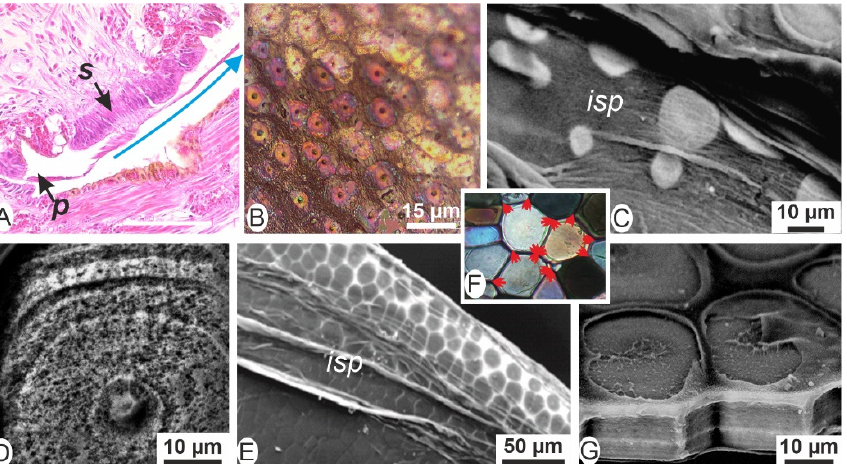
Figure 6. Role of the periostracum in the formation of the shell outer layer. ( A ) Histological view showing the origin of the periostracum ( p ) in the deeper part of the outer mantle grove and the first secretion onto its inner surface ( s )—Image credit: A. Fougerouse, DRM. Periostracum is continu- ously secreted (on a stepping mode) and it progresses towards the shell growth edge (blue arrow). ( B ) Statistical deposition of the organic centers surrounded by the earliest secondary deposition. ( C ) Mineralized disks whose diameters progressively increase. ( D ) Stepping mineralization of the disks forming concentric rings surrounding the initial center. ( E ) Disk reaching the shell growing edge visible through the internal side of the periostracum ( isp ). ( F ) Deposition of calcium carbonate by the mantle contributes to create the rigid shell. ( G ) Oblique view of the shell prisms showing their outer sides made by the partly decayed periostracum with the underlying disks and the first common growth steps of the